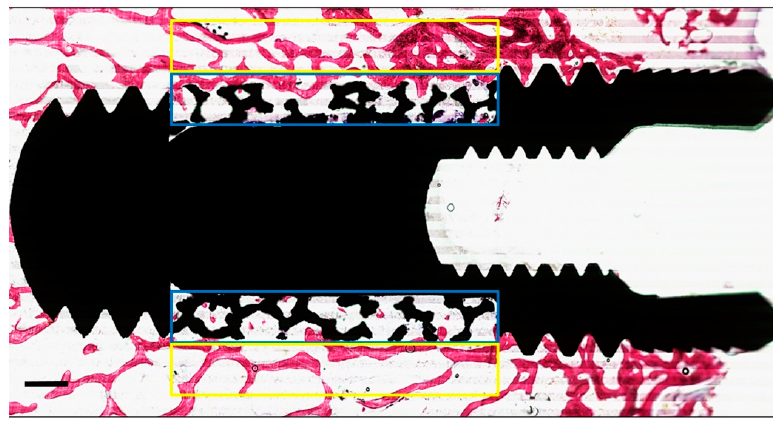
Figure 3. Representative of the two regions of interest (ROI) on either side of the implant. The “yellow box” corresponds to the area outside the porous structure used to measure the peri-implant bone area (PIBA%). The “blue box” corresponds to the area inside the porous structure used to measure bone growth area (BGA%). The mean values obtained from the two ROI were calculated per implant. (Scale bars = 0.5 mm).